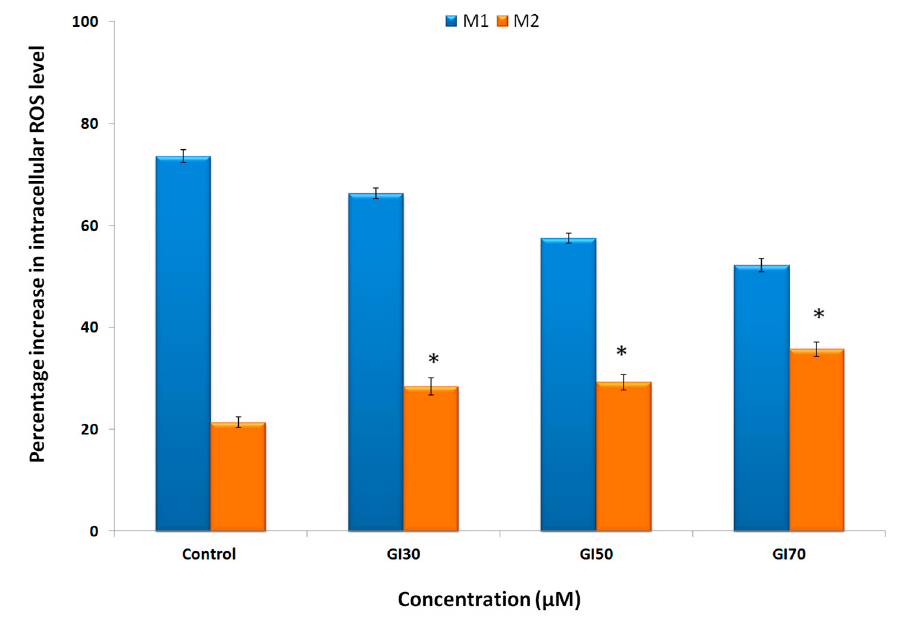
Figure 12. Effect of Epiafzelechin from C. fistula on the generation of intracellular reactive oxygen species (ROS) in MG-63 cells (24 h). 2 ′ ,7 ′ -dichlorofluorescein diacetate (DCFH-DA) was used to stained the cells, 20,000 events were acquired and the gated population analyzed using flow cytometer. M1 represents intact cell population and M2 represents cells with accumulation of intracellular ROS. * indicates a statistically significant difference at ( p ≤ 0.05).